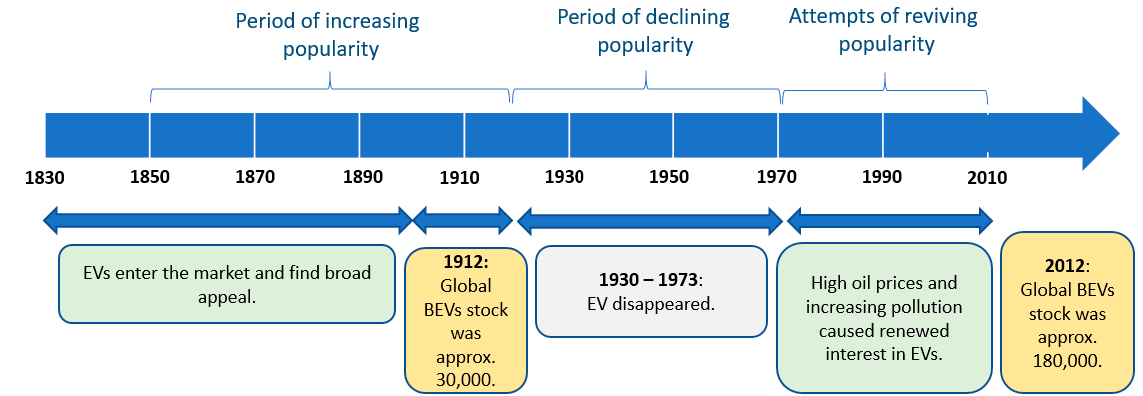
Figure 4. Major milestones in the history of battery electric vehicles.